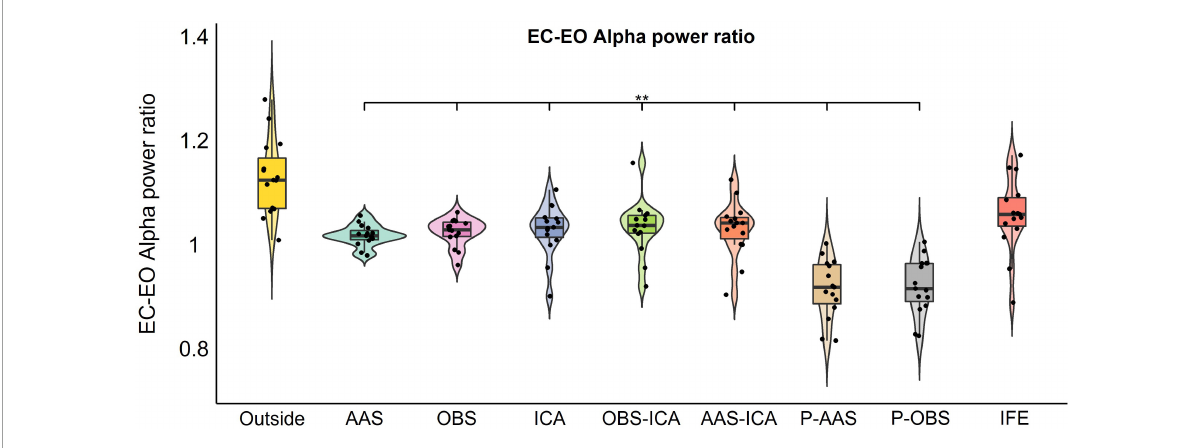
FIGURE6 Results of the repeated measures ANOVAs comparing the eyes closure-opening (EC-EO) alpha power ratio calculated from O1 and O2 electrodes for the Outside EEG EC-EO and the EEG-fMRI EC-EO signals corrected with each BCG approach or Independent component analysis Feature Extraction (IFE). The asterisks indicate significant statistical differences ( p adj < 0.05) between the EEG-fMRI EC-EO and the Outside EEG EC-EO data. IFE was the only method that did not show significant differences in the EC-EO alpha power ratio when compared to the data recorded outside the scanner. Note that PROJIC-AAS and PROJIC-OBS were abbreviated as P-AAS and P-OBS,